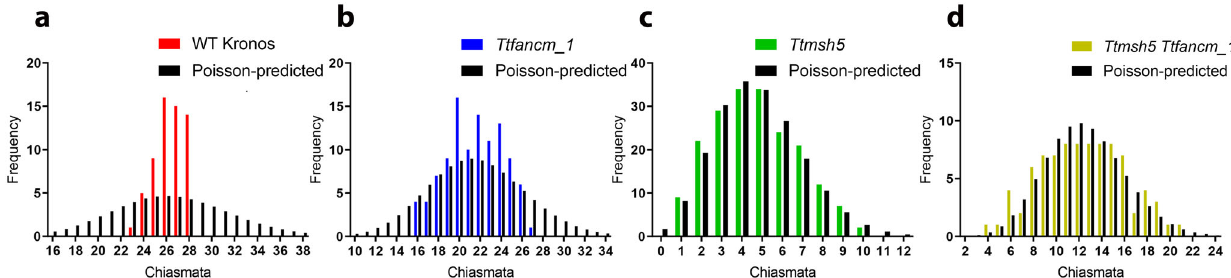
Fig. 3 FANCM limits class II crossovers. a – d Observed and Poisson-predicted distributions of chiasma frequency per cell. a The observed wild-type distribution of chiasmata deviates signi fi cantly from a Poisson-predicted distribution ( χ 2 (28) = 113.16, n = 60, p < 0.01, Chi-squared test). b The distri b ution of chiasmata in Ttfancm_1 deviates signi fi cantly from a Poisson-predicted distribution ( χ 2 (26) = 38.9, n = 104, p < 0.05, Chi-squared test). c The distribution of c hiasmata in Ttmsh5 does not deviate signi fi cantly from a Poisson-predicted distribution ( χ 2 (14) = 5.63, n = 194, p ≥ 0.975, Chi-squared test). d The distribution of chiasmata in Ttmsh5 Ttfancm_1 does not deviate signi fi cantly from a Poisson-predicted distribution ( χ 2 (20) = 9.74, n = 86, p > 0.95, Chi- squared test). Source data are provided as a Source Data fi le.